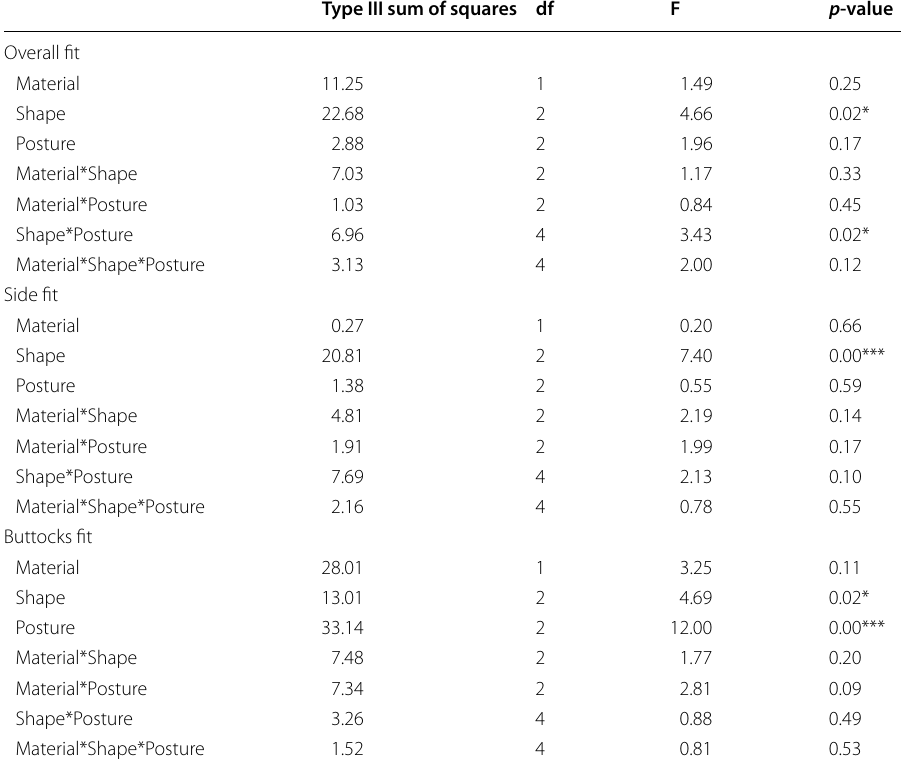
Table 4 Subjective fit evaluation depending on material, shape, and posture (repeated measures